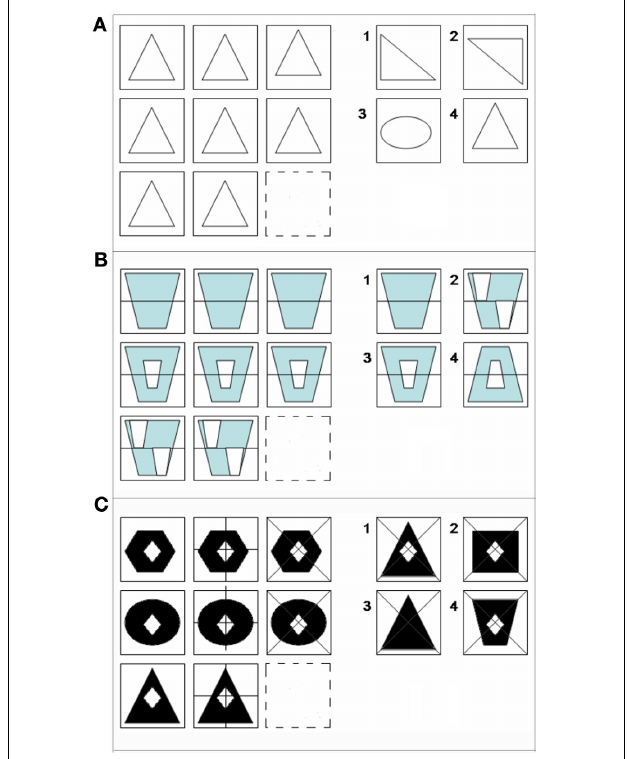
FIGURE 1 | Examples of matrix reasoning stimuli at (A) 0-relational, (B) 1-relational, and (C) 2-relational complexity. All matrix problems were experienced in No-Color (A) , Color (B) , and Black-white visual contrast (C)